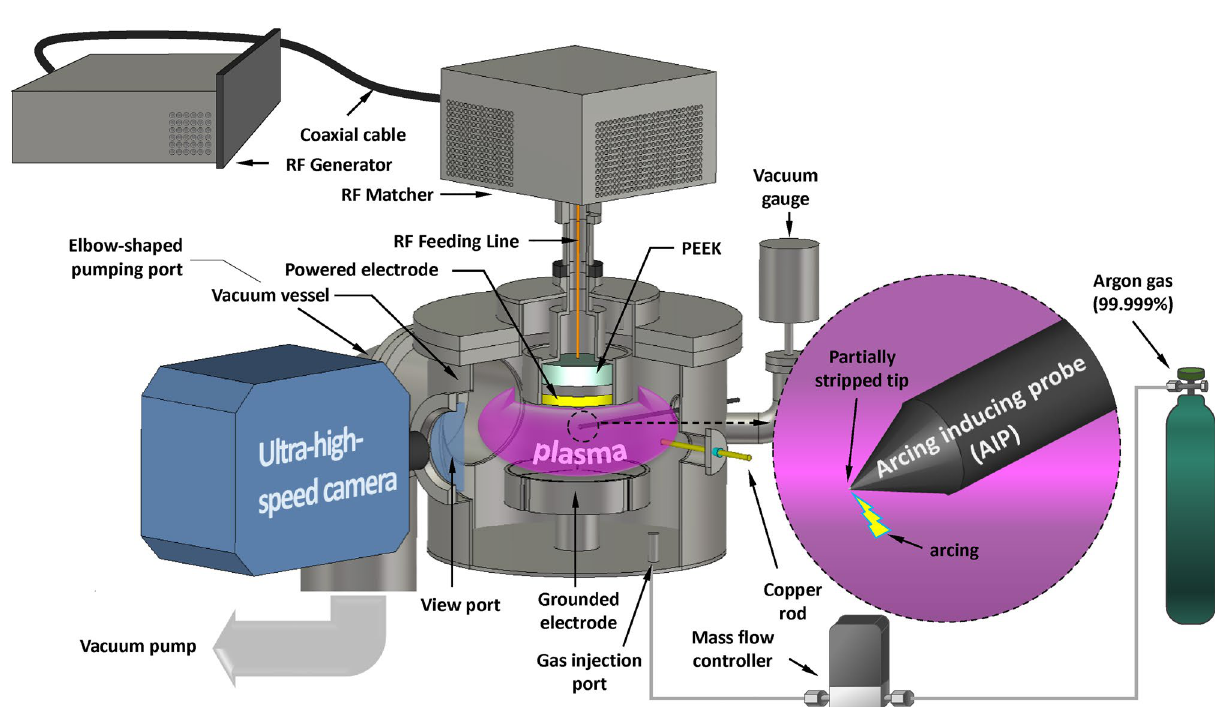
Figure 2. Semi-cross-sectional schematic of the experimental setup